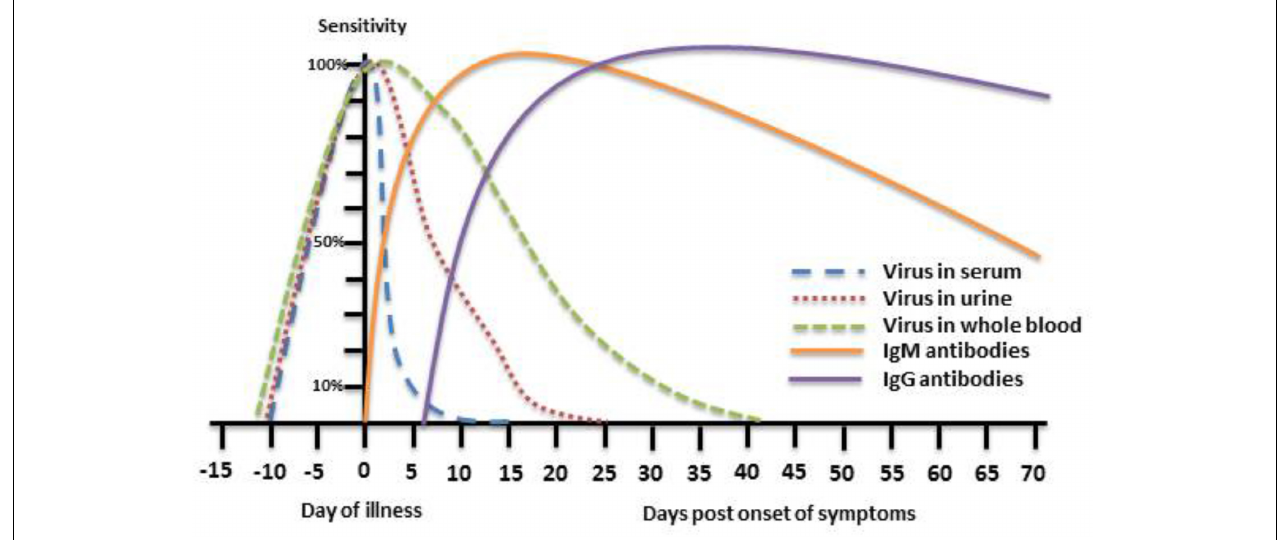
FIGURE 1 | Theoretical depiction of WNV presence in body fluids and WNV immune response. The phases of WNV detection period in serum, urine, and whole blood as well as the IgM and IgG immune response to WNV infection are presented with respect to the day of